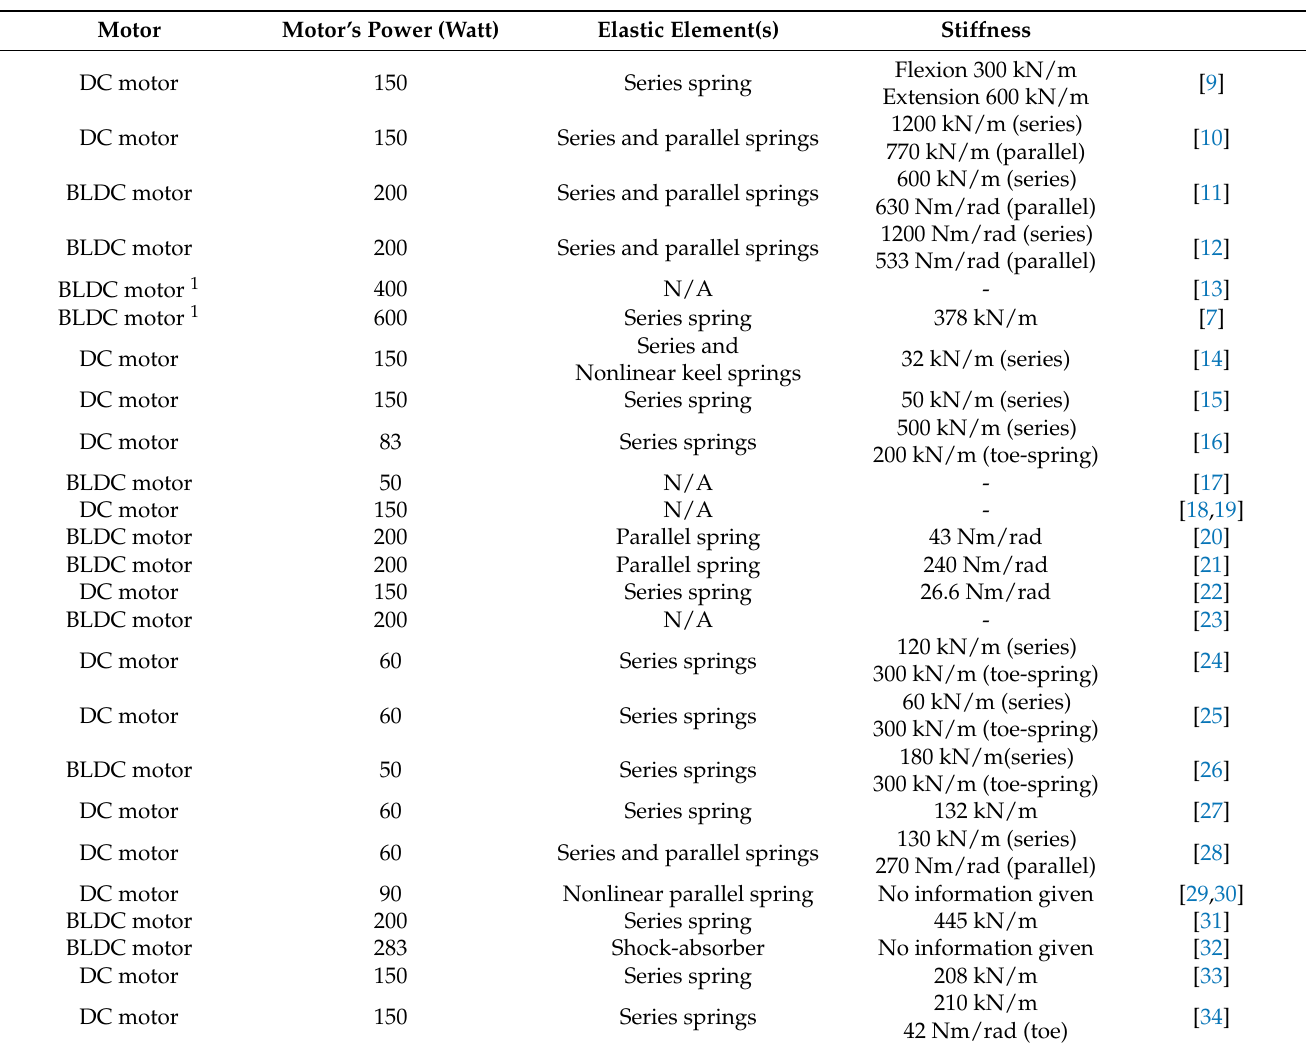
Table 1. Powered ankle–foot prosthesis actuator design